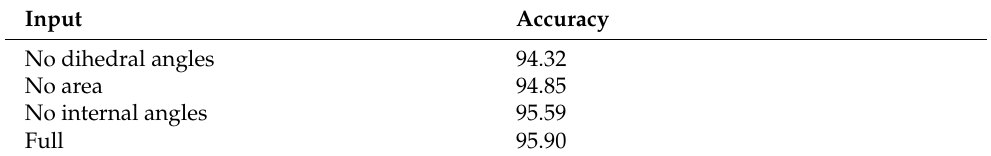
Table 5. Ablation experiments of the input features on the COSEG vases for segmentation.